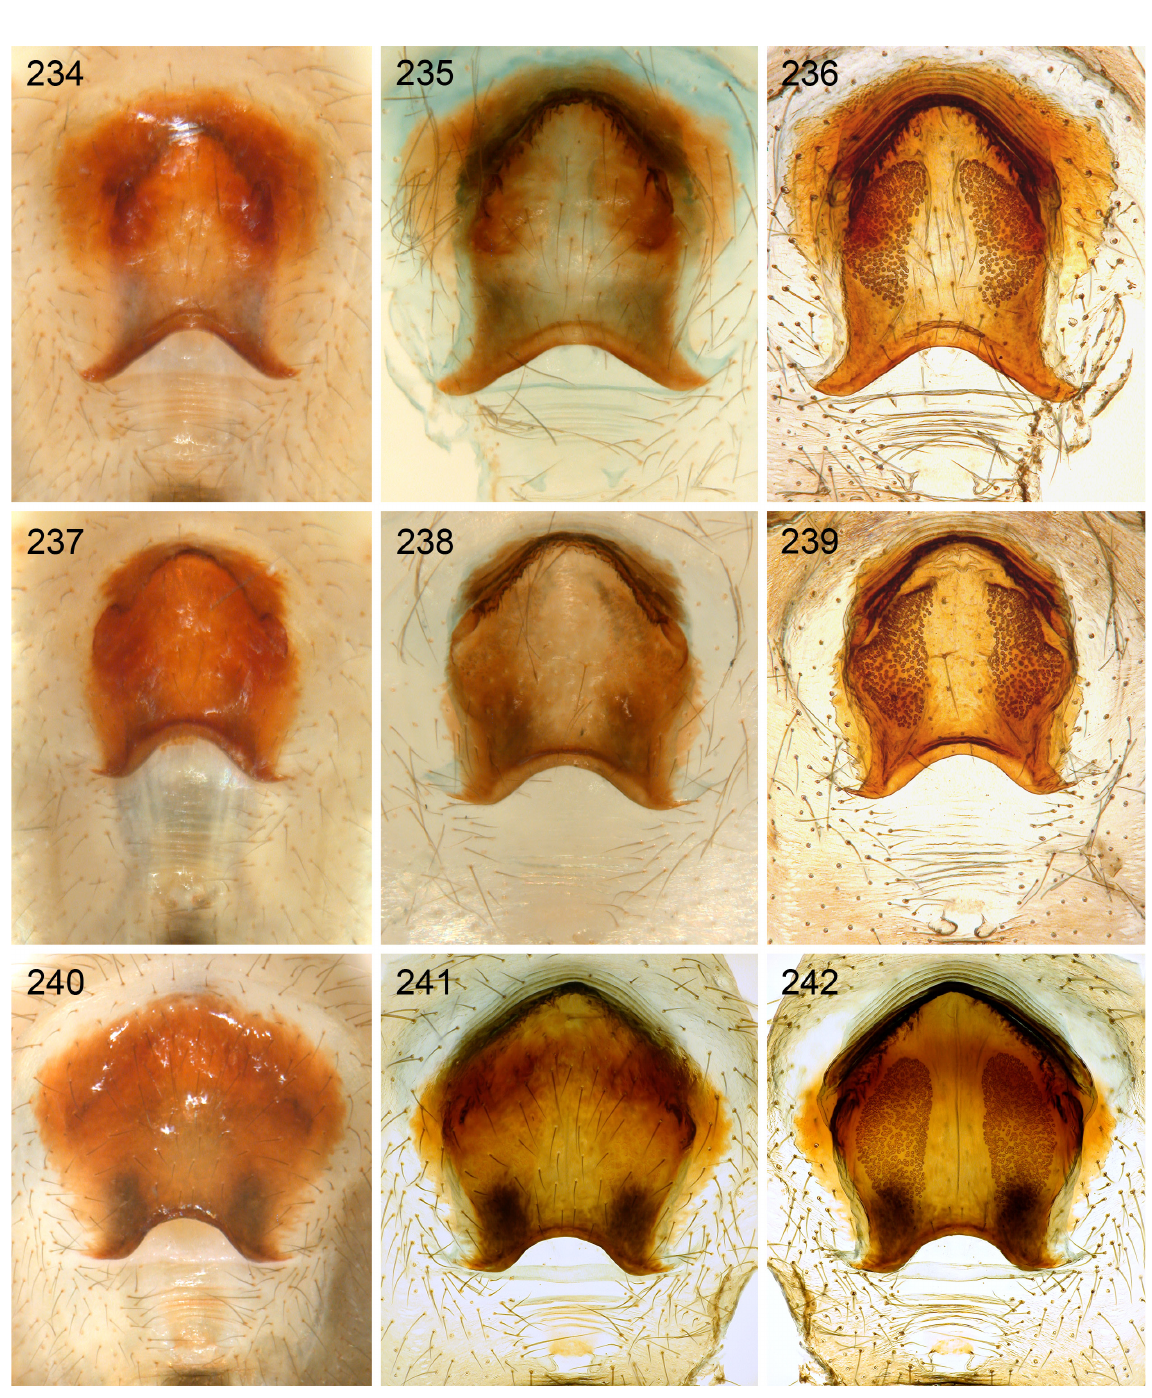
Figs 234–242. Aetana omayan group, female genitalia, part 2 (cf. Figs 213–218); untreated in ventral view, cleared in ventral and dorsal views. — 234–236 . A. manansalai Huber, sp. nov. — 237–239 . A. lozadae Huber, sp. nov. — 240–242 . A. banahaw Huber,